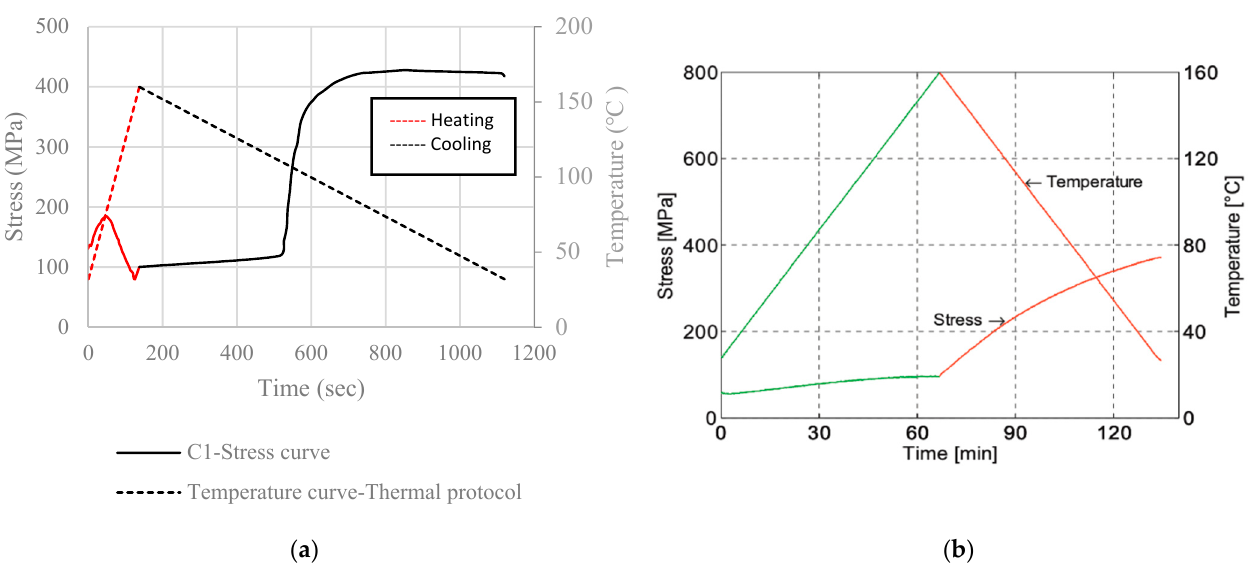
Figure 11. ( a ) Stress–time–temperature graph, specimen C1; and ( b ) stress–time–temperature graph, Ghafoori et al. [40].